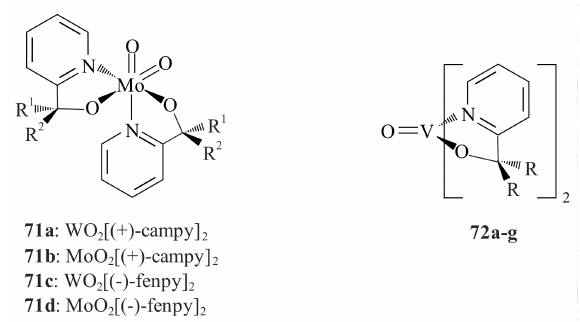
Figure 13. Chiral Mo and achiral V